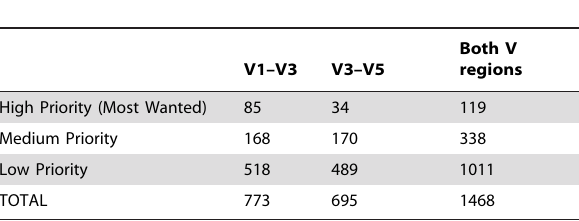
Table 2. The number of OTUs determined to be ‘‘high priority’’, ‘‘medium priority’’ or ‘‘low priority’’ for full genome